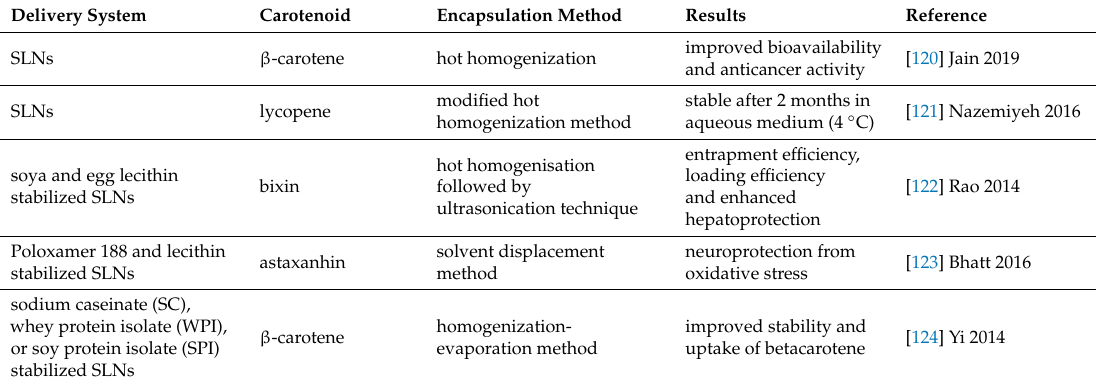
Table 5. Solid lipid nanoparticles (SLNs) as delivery system for carotenoid